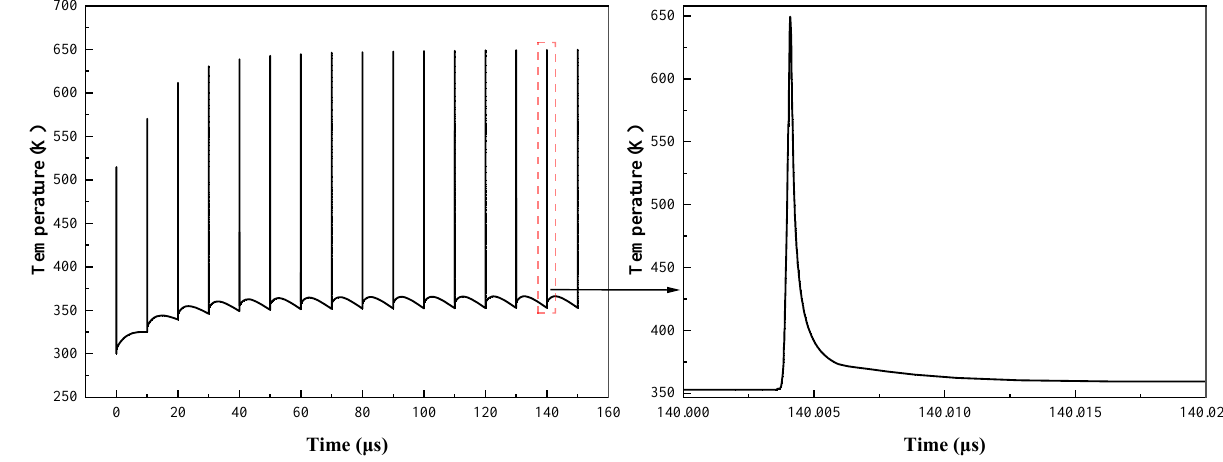
Figure 5. Variations in peak temperature over time inside the pHEMT. When the UWB EMP arrives, the peak temperature inside the device rises sharply and drops rapidly after the pulse. The reason for the second rise after the temperature drop is that the device is still in the conduction state with the UWB voltage at 0 V at the time. It can be seen from Figure 5 that the internal temperature of the HEMT only accumulates in the first few cycles. After a period of time, the heat accumulated by the UWB EMP and the relaxation time of the internal cooling of the device reaches a balance. Thus, the heat no longer accumulates, and the internal temperature of the device no longer